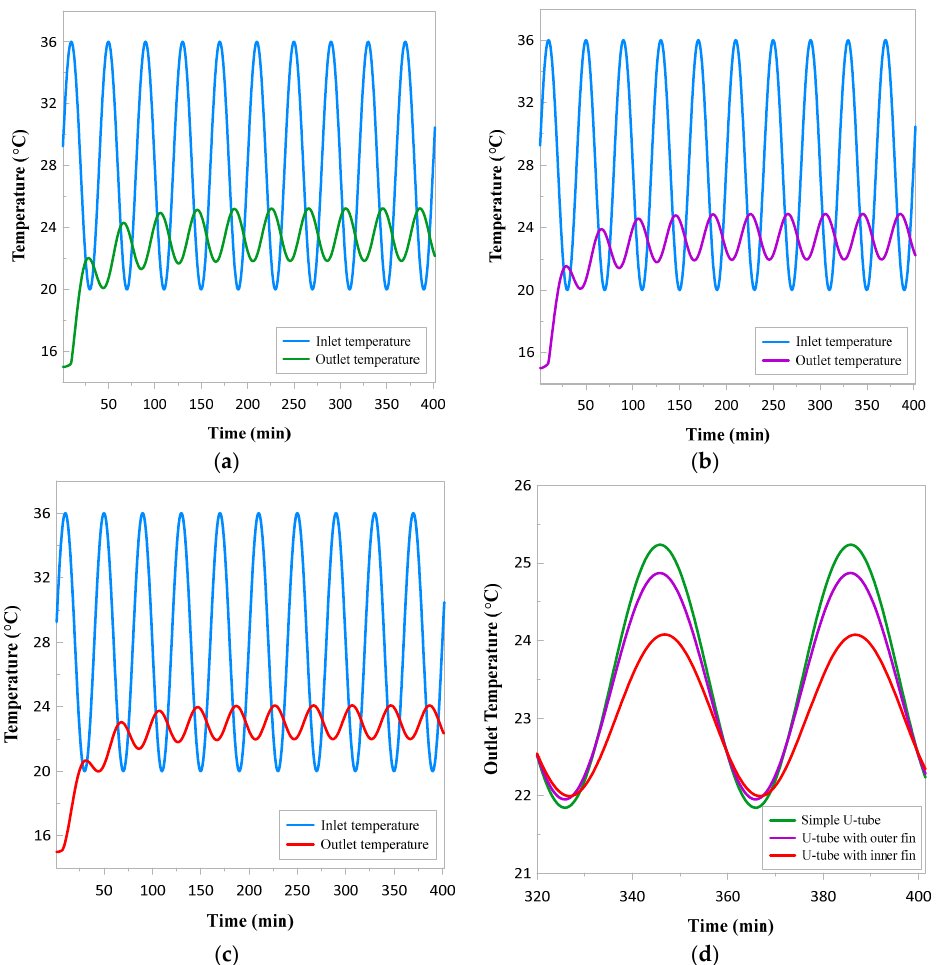
Figure 7. Fluid inlet and outlet temperatures with a frequency of 1/2400 Hz: ( a ) simple U-tube; ( b ) U-tube with outer fins; ( c ) U-tube with inner fins; ( d ) comparison of fluid outlet temperatures in three simple and finned U-tubes.